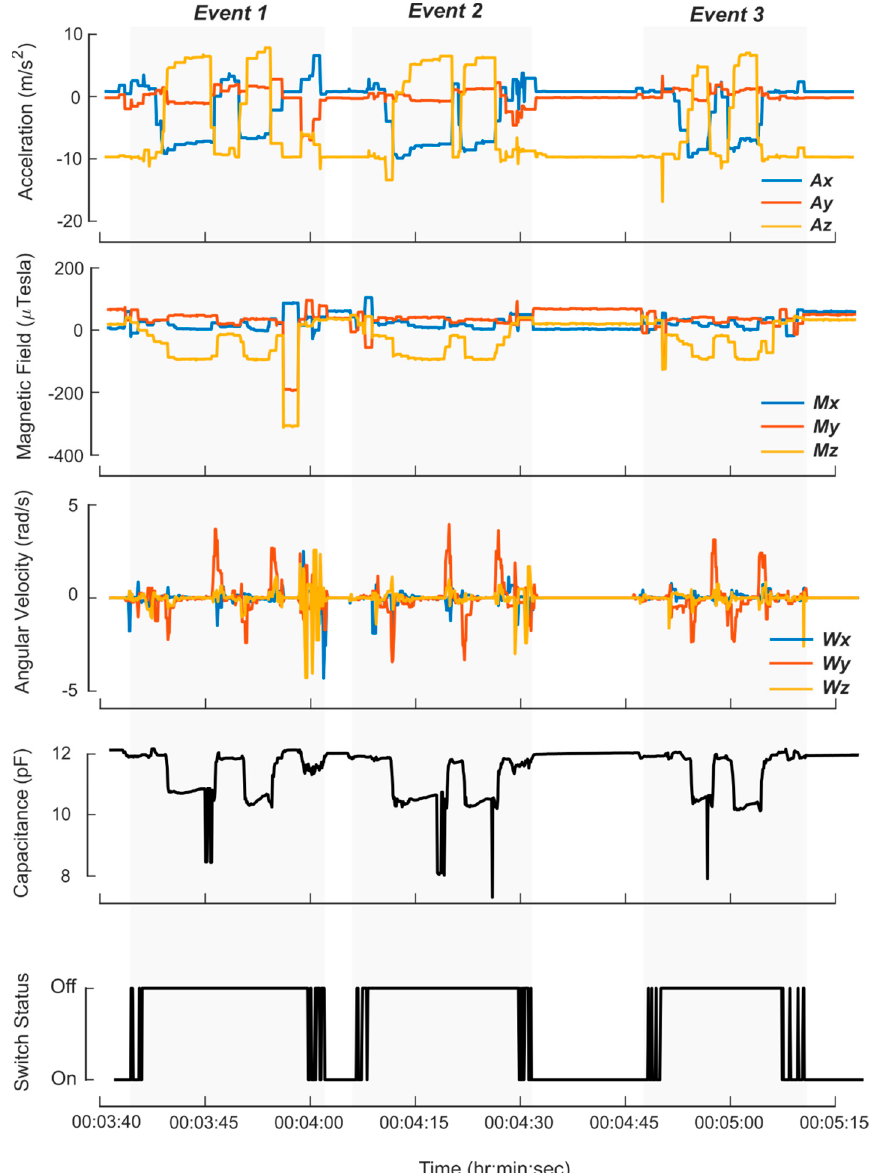
Figure 6. Data from the sleeve during three consecutive use events. Reed switch status indicates cap state (on or off). When the bottle was inverted, there was a change in orientation most clearly visible in the accelerometer data. The changing angular velocity at the beginning and end of each application was present in the recorded angular velocity. Data from the capacitance sensor showed the initial drop in capacitance was due to movement of the fluid into the top of the bottle, and then the additional drop in was capacitance created as the droplets were dispensed.